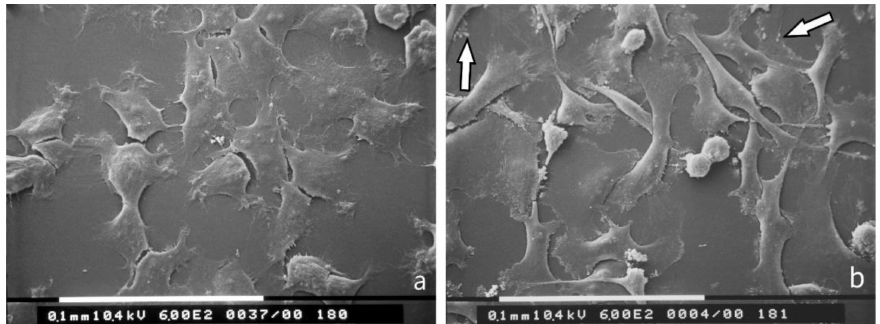
Figure 1. 2D cultures in polystyrene flasks of breast cancer cells observed at SEM. ( a ) Most of the MCF-7 cells appear grouped with many cell-cell contacts and show a flattened, smoothly polygonal shape with very few cytoplasmic microvilli and rare cytoplasmic vesicles. Bar 100 µ m; ( b ) MDA-MB-231 cells are presented as isolated cells with very few cell-cell contacts. These cells appear as globular/spherical cells, flattened elongated cells and spindle-like cells with a few cytoplasmic vesicles (arrows). Bar 100 µ